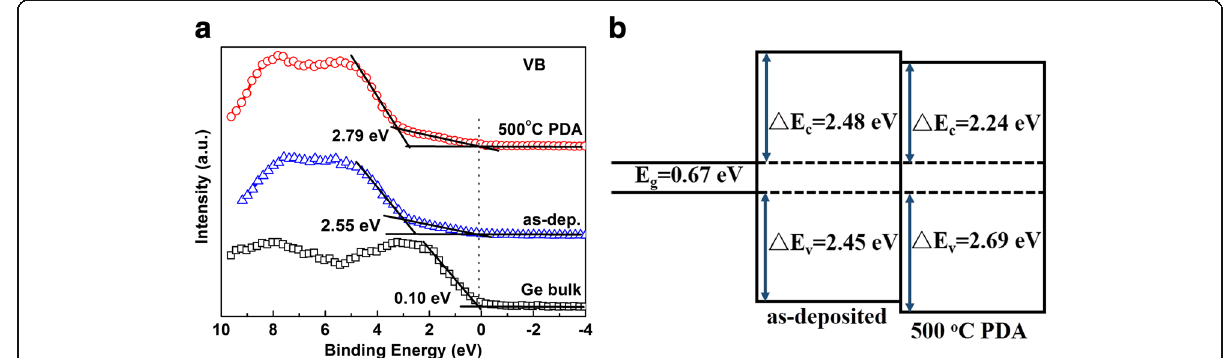
Fig. 5 Band alignment of as-deposited and annealed HfO 2 /SiO 2 film on Ge. a Valence-band spectra of the Ge substrate, as-deposited and annealed HfO 2 /SiO 2 films. b Schematic of band alignment of as-deposited and annealed HfO 2 /SiO 2 film on